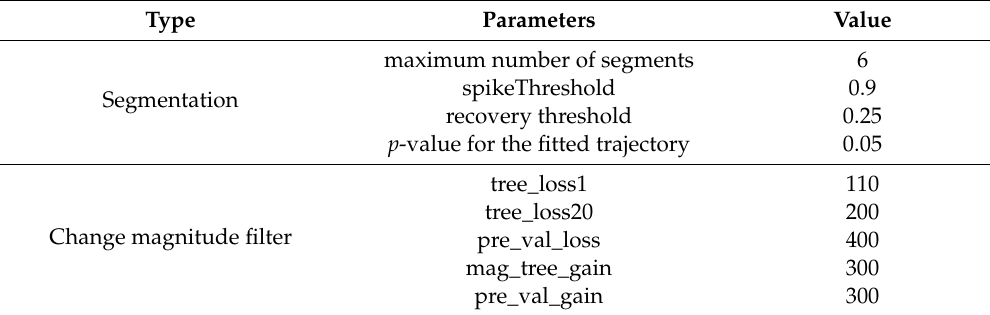
Table A1. Selected parameters to perform time spectral segmentation in LT algorithm.